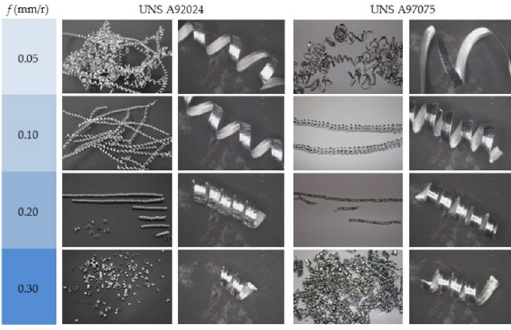
Figure 5. Chip macro-geometrical evolution as a function of feed.